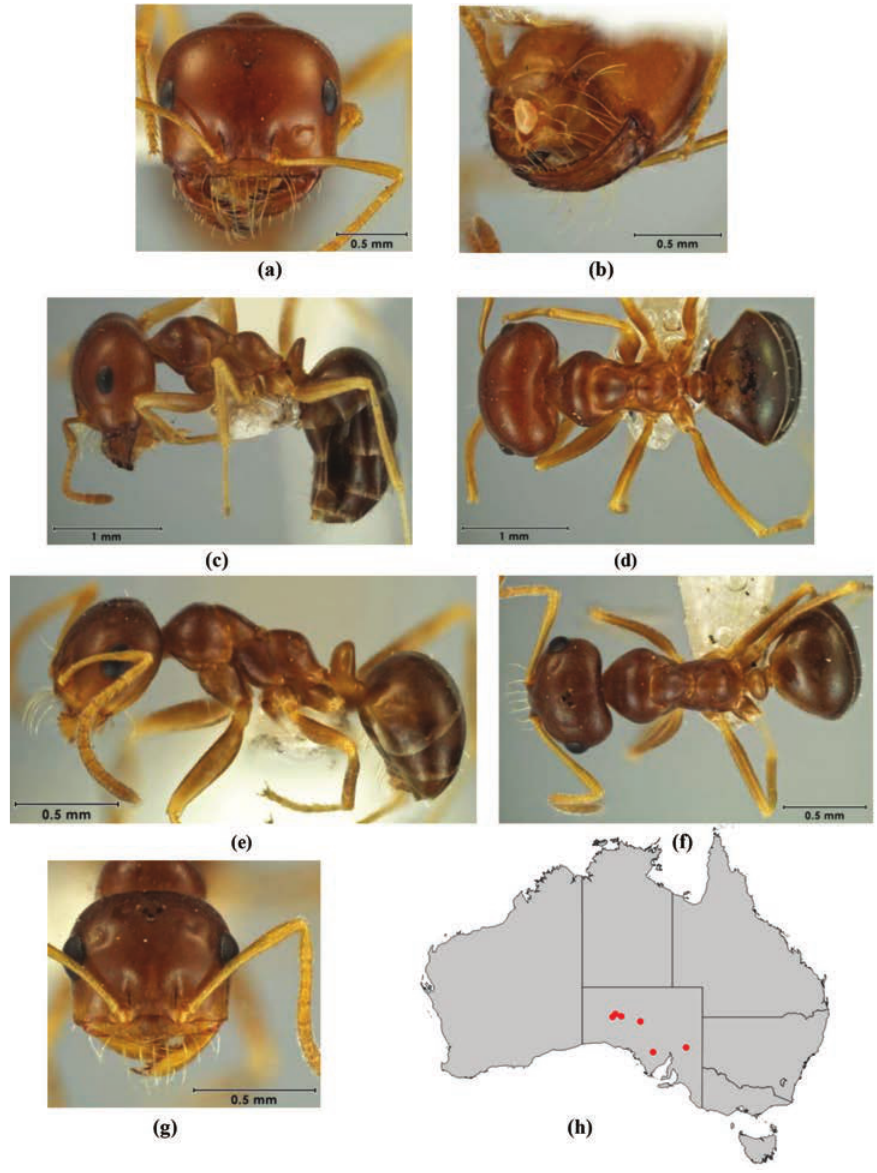
Figure 76. Melophorus brevipalpus sp. n.: major worker paratype (ANIC32-066590–top ant) frons ( a ), underside of head showing palps ( b ); profile ( c ) and dorsum ( d ); minor worker holotype (ANIC32- 066590–bottom ant) frons ( e ), profile ( f ) and dorsum ( g ); distribution map for the species ( h